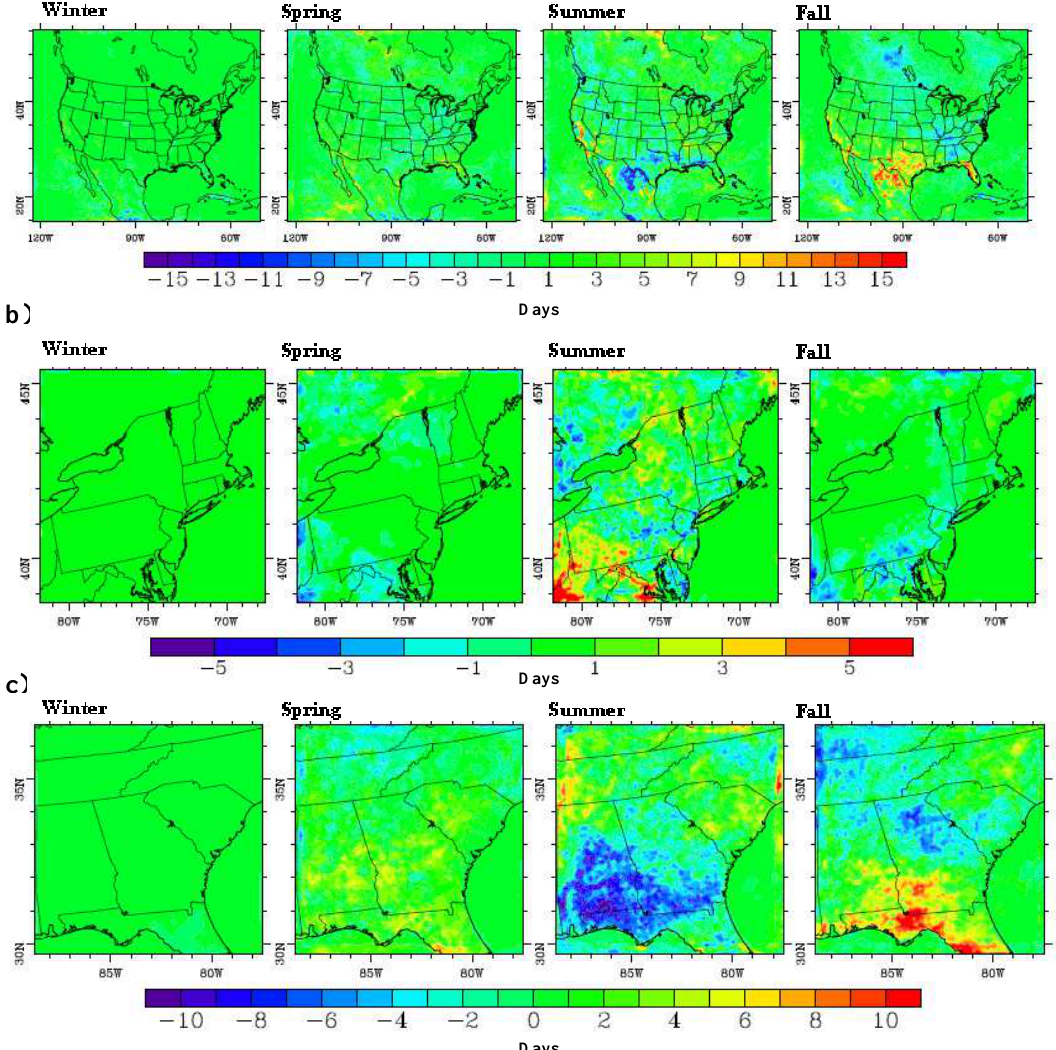
Figure 5: Predicted total seasonal change in the number of stagnation days (days per season) (future minus historic) for (a) the 36km × 36km resolution modeling domain, (b) the 12km × 12km resolution sub-domain over the Northeast and (c) the 12km × 12km resolution sub-domain over the Southeast.